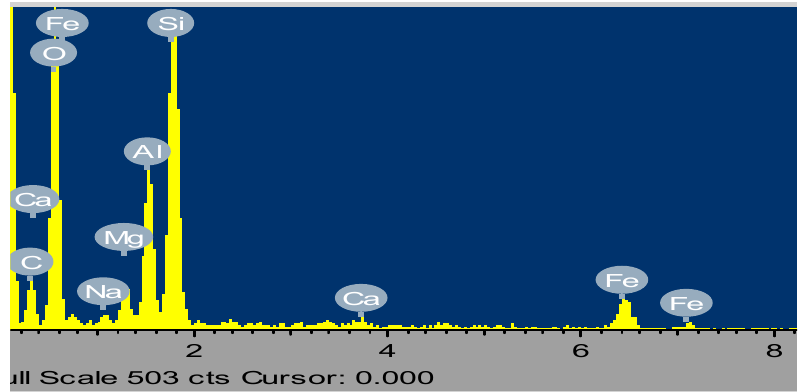
Figure 2. Energy dispersal spectroscopy (EDS) of the activated clay sample.